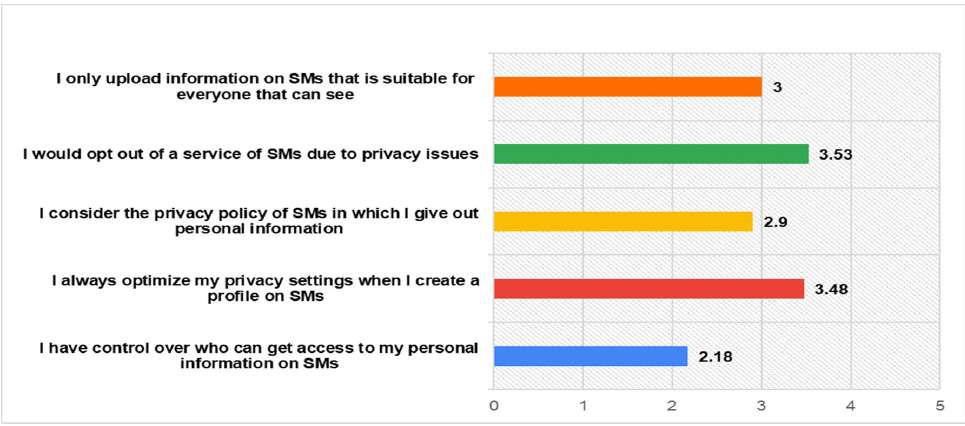
Figure 4. Privacy Control.